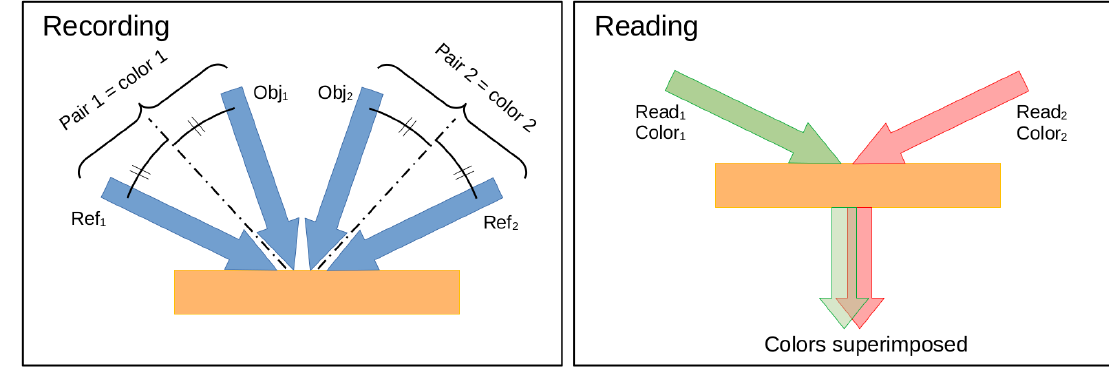
Figure 8. Schematic diagram for recording ( left ) and displaying ( right ) of a 2-color hologram with a photorefractive polymer. By using all these different techniques, large, full color, quickly refreshable holo- graphic stereograms have been recorded in photorefractive polymers. An example of such hologram is presented in Figure 9. Seen in real life, these holograms present vivid colors and striking 3D features, such as occlusions and parallax rendering.